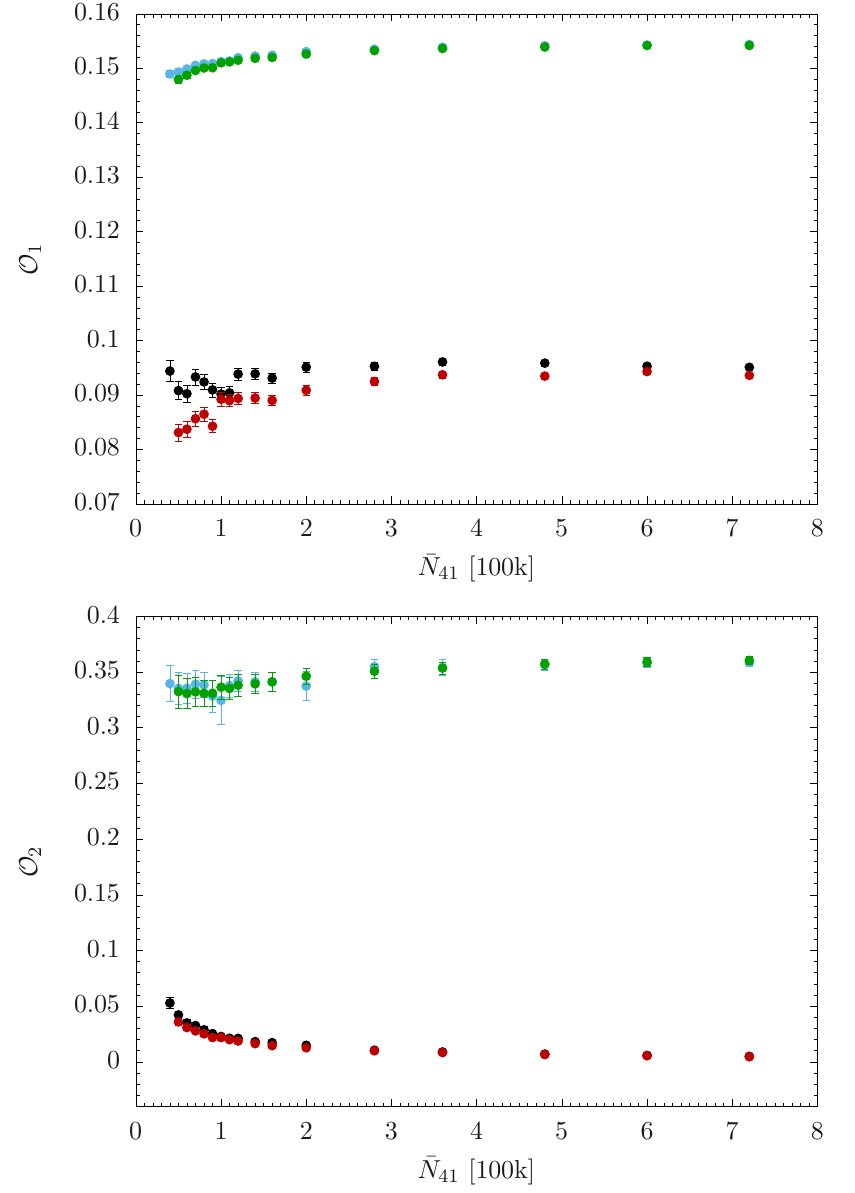
Figure 6 . The order-parameters The colors correspond to the convention used in (cid:12)gure 2.